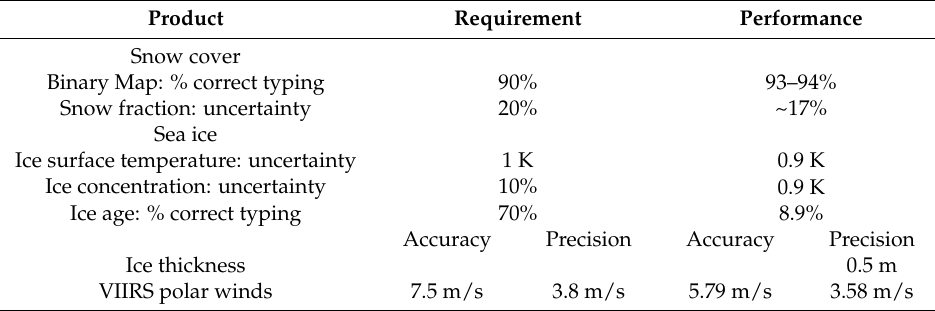
Figure 9. The VIIRS Cryosphere products are all operationally produced from the S-NPP and meet APU requirements. (Figure courtesy: Jeff Key, STAR Cryosphere team). Table 8. S-NPP VIIRS cryosphere products performance.